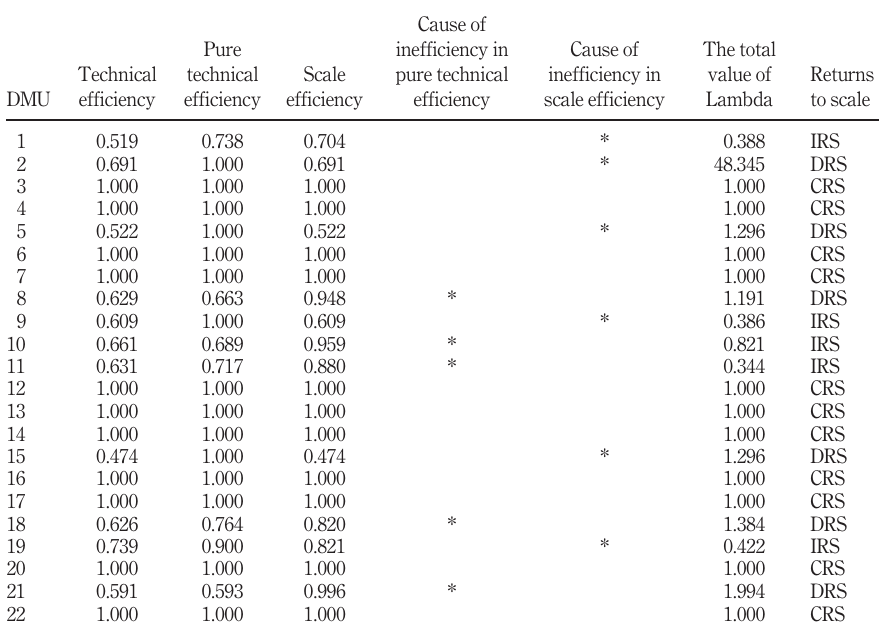
Table VII. Cause of inef fi